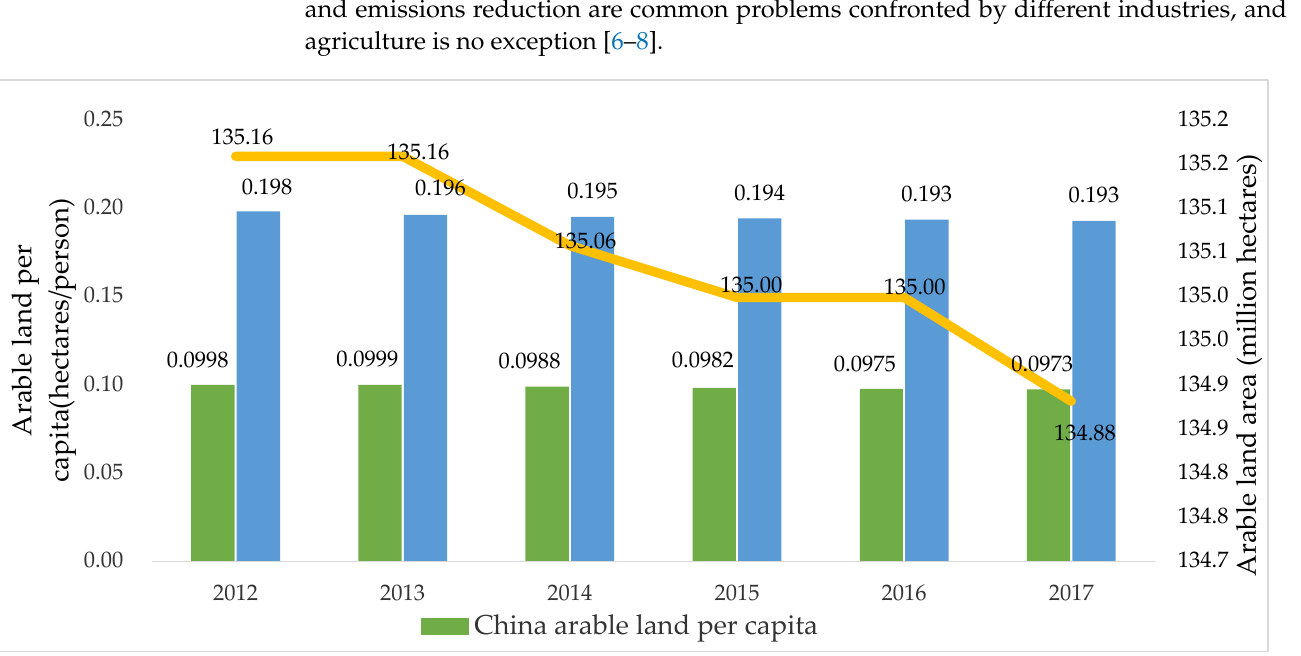
Figure 1. China’s agricultural cultivated land area chart: 2010–2017. Data source: Industry Consulting Expert in China https://www.huaon.com/story/393954 (accessed on 18 May 2022). National Bu- reau of Statistics of China. https://www.askci.com/news/chanye/20181126/1459421137475.shtml(accessed on 18 May 2022).